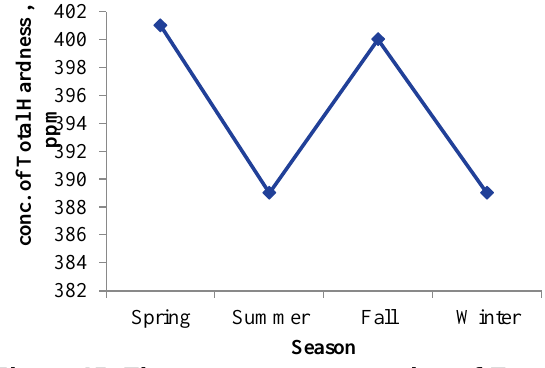
2 shows the data for different negative correlation